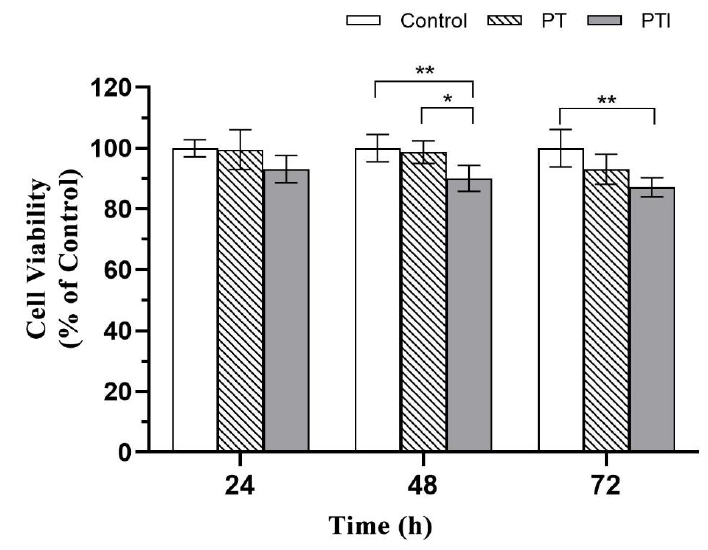
Figure 5. Cytotoxicity of scaffold extracts in each group. * p < 0.05, ** p < 0.01.